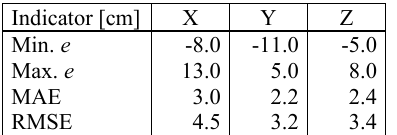
Table 1. Basic statistical indicators for point cloud coordinate